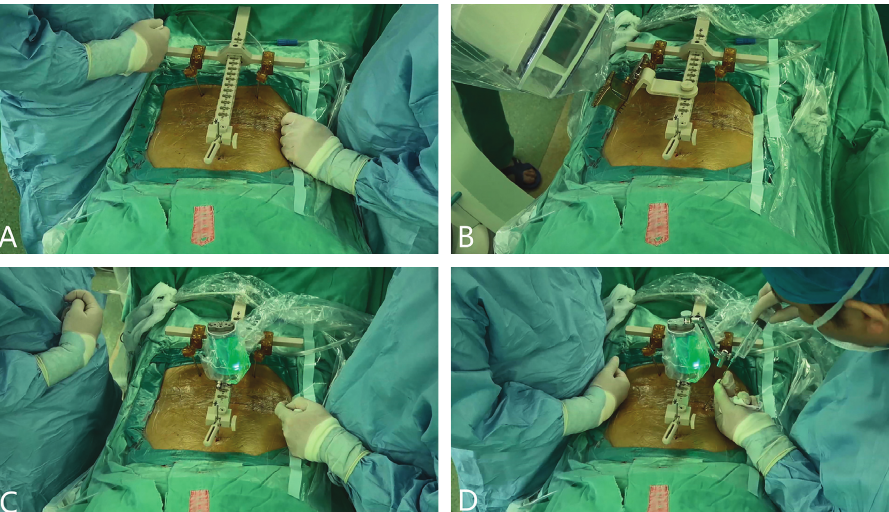
Figure 2: The Hover-Tframe platform was fixed on the patient’s spine (a); an anteroposterior image and an image 60 ° oblique to the plane were captured by the C-arm for registration with the preoperative CT (b); the guiding robot moved on the platform according to the preoperative plan (c); local infiltration anesthesia around the facet joints before drilling (d).